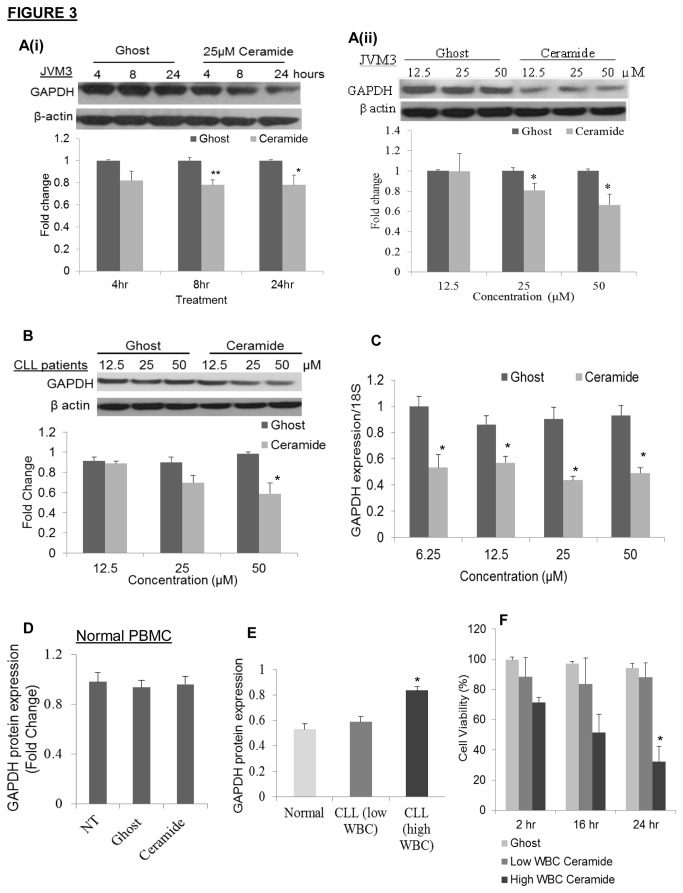
C6-ceramide nanoliposomes target GAPDH in CLL.A). JVM3 cells were treated with (i) 25µM of ghost or C6-ceramide nanoliposomes for varying times, (ii) varying doses of ghost or C6-ceramide nanoliposomes for 24 hours, then Western Blot analysis was performed for GAPDH. Densitometry analysis from replicate experiments (n=4) was performed via ImageJ software. In Figure A(ii) the representative blot demonstrates a decrease in GAPDH at 12.5µM C6-ceramide, a result not observed in the other two distinct replicate experiments. * P < 0.05; ** P <0 .005. B). CLL patient cells (n=3, analyzed individually) were treated with different doses of ghost or C6-ceramide nanoliposomes for 24 hours, then Western Blot analysis was performed for GAPDH. * P < 0.05. The blot represents the effect of C6-ceramide nanoliposomes on one patient sample, however, the graph is an average of the effect on all three patient cells. C). JVM3 cells were treated with different doses of ghost and C6-ceramide nanoliposomes for 24 hours, then qRT-PCR analysis was performed for expression of GAPDH mRNA. Expression was normalized to 18S. * P < 0.05. D). PBMC from normal donors (n=3) were treated with 25 µM ghost or C6-ceramide nanoliposome for 24 hours and then Western Blot analysis was performed for GAPDH. E). Basal protein expression of GAPDH was determined via Western Blot analysis on PBMC isolated from normal donors (n=8) or from CLL patients with either a lower WBC count (n=9) or higher WBC count (n=5). Patients with WBC counts >50,000 cells/µL were identified as patients with high WBC count. * P < 0.05. F). CLL patient cells with either a lower WBC count (n=4) or higher WBC count (n=3) were treated with 25µM ghost or C6-ceramide nanoliposomes for 2, 16 and 24 hours then an MTT assay was performed * P < 0.05.